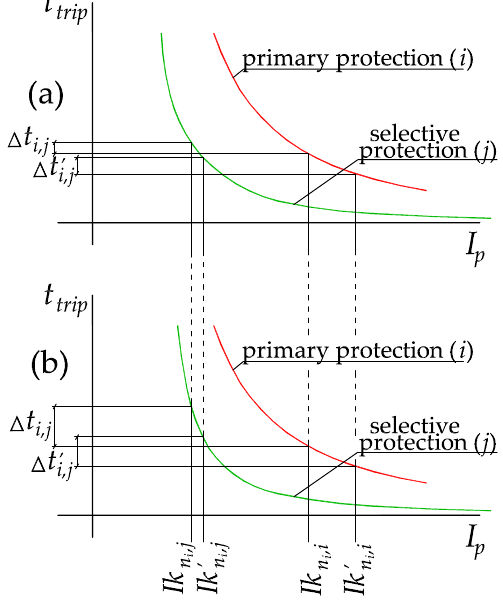
Figure 5. Sensitivity of selectivity for different short-circuit contributions flowing through primary and selective protections. ( a ) higher sensitivity occur for Ik n